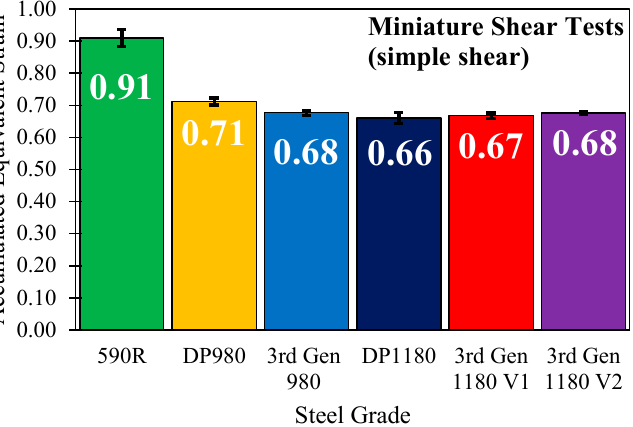
Figure 28. Integrated failure strains under simple shear loading. Note that the data for the DP1180 was retrieved from the Numisheet 2022 Benchmark [16].